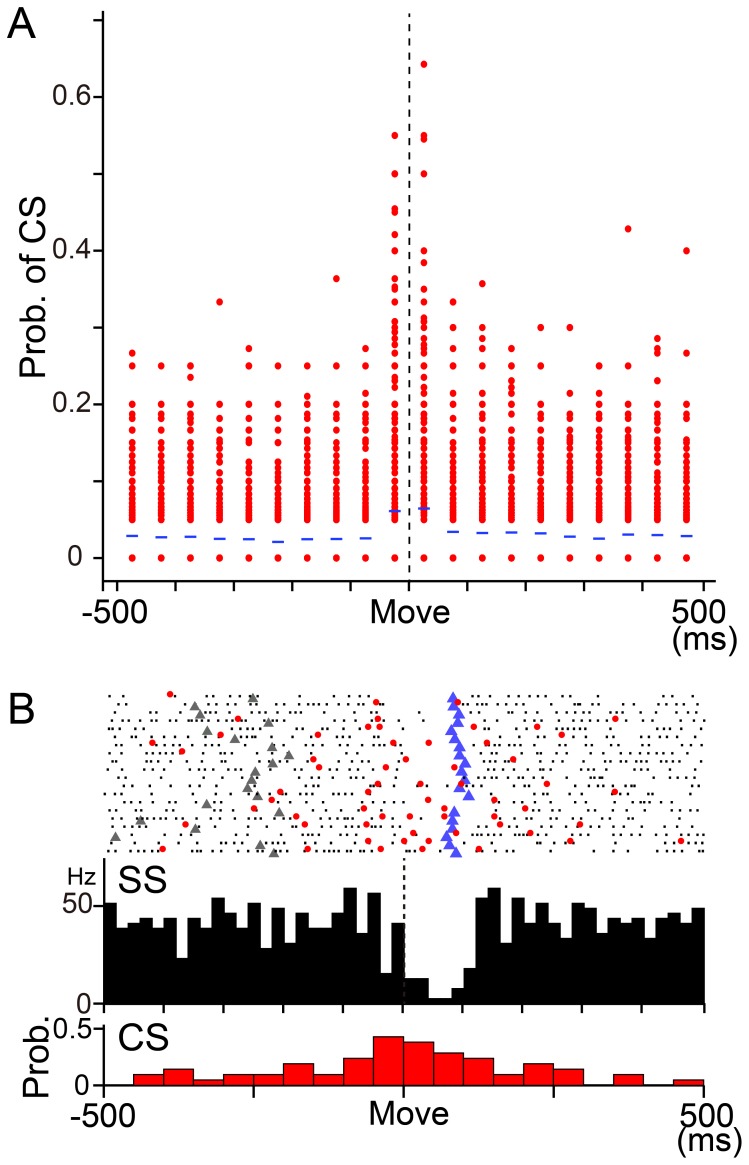
Movement-related CS activity in PCs.A: Probability of complex spike firing in 50 ms bins from −500 to 500 ms relative to movement onset in monkey M. Data from all movement directions in all PCs recorded in the pronated posture were plotted (n = 600, 8 directons ×75 PCs) in each bin. A probability of 1 means that a CS was observed in every trial in that time bin for a direction of movement in a PC. Note that the probability was 0 in more than half of PCs in each time bin, except for the bins right before and after movement onset. B: Raster plots and histograms of SS and CS simultaneously recorded in a PC. SS and CS showed a tendency of reciprocal activity around movement onset. Black dots: SS, red dots: CS, gray triangles: Go cue, blue triangles: timing of maximum velocity. Upper histogram: SS activity, 1 bin  = 20 ms. Vertical dashed line indicates movement onset. Lower histogram: CS activity, 1 bin  = 50 ms. Prob.: probability of occurrence of CS.